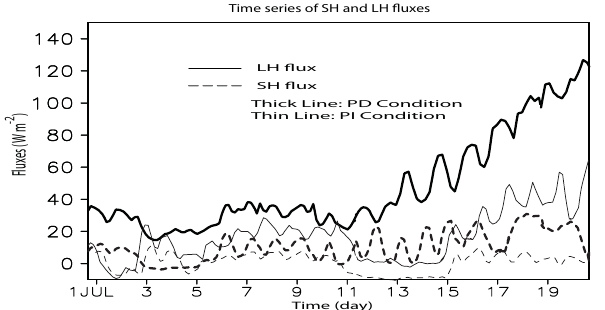
Fig. 3. Time series of the surface SH and LH fluxes (W m − 2 ) for the CSRM runs.